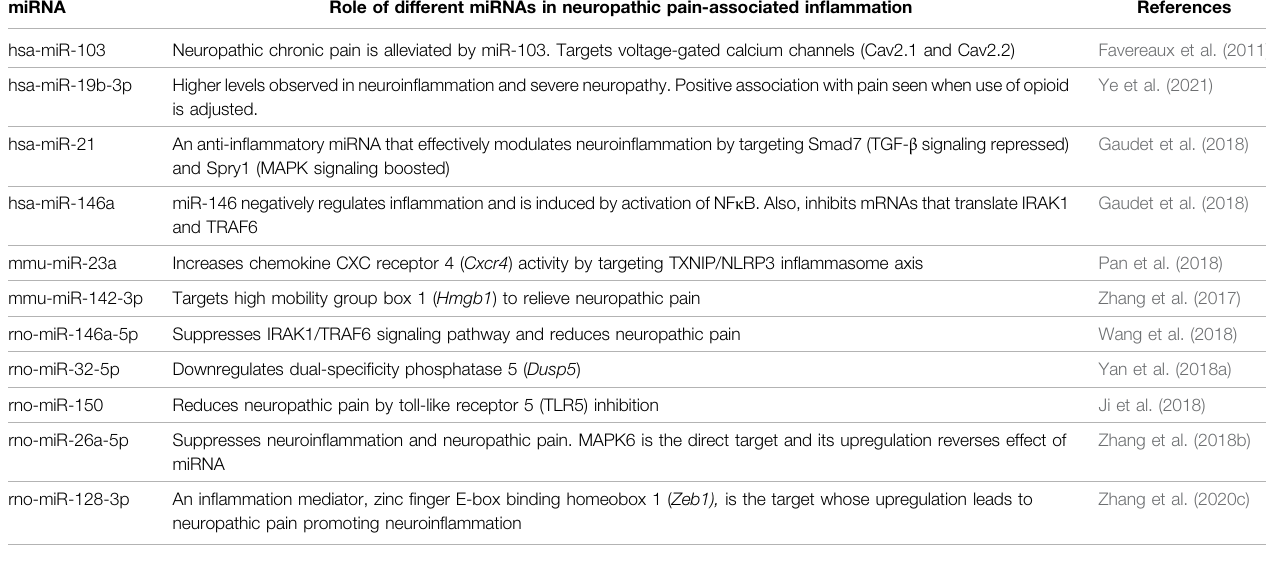
TABLE 7 | Role of different miRNAs in neuropathic pain-associated in fl ammation. miRNA Role of different miRNAs in neuropathic pain-associated in fl ammation